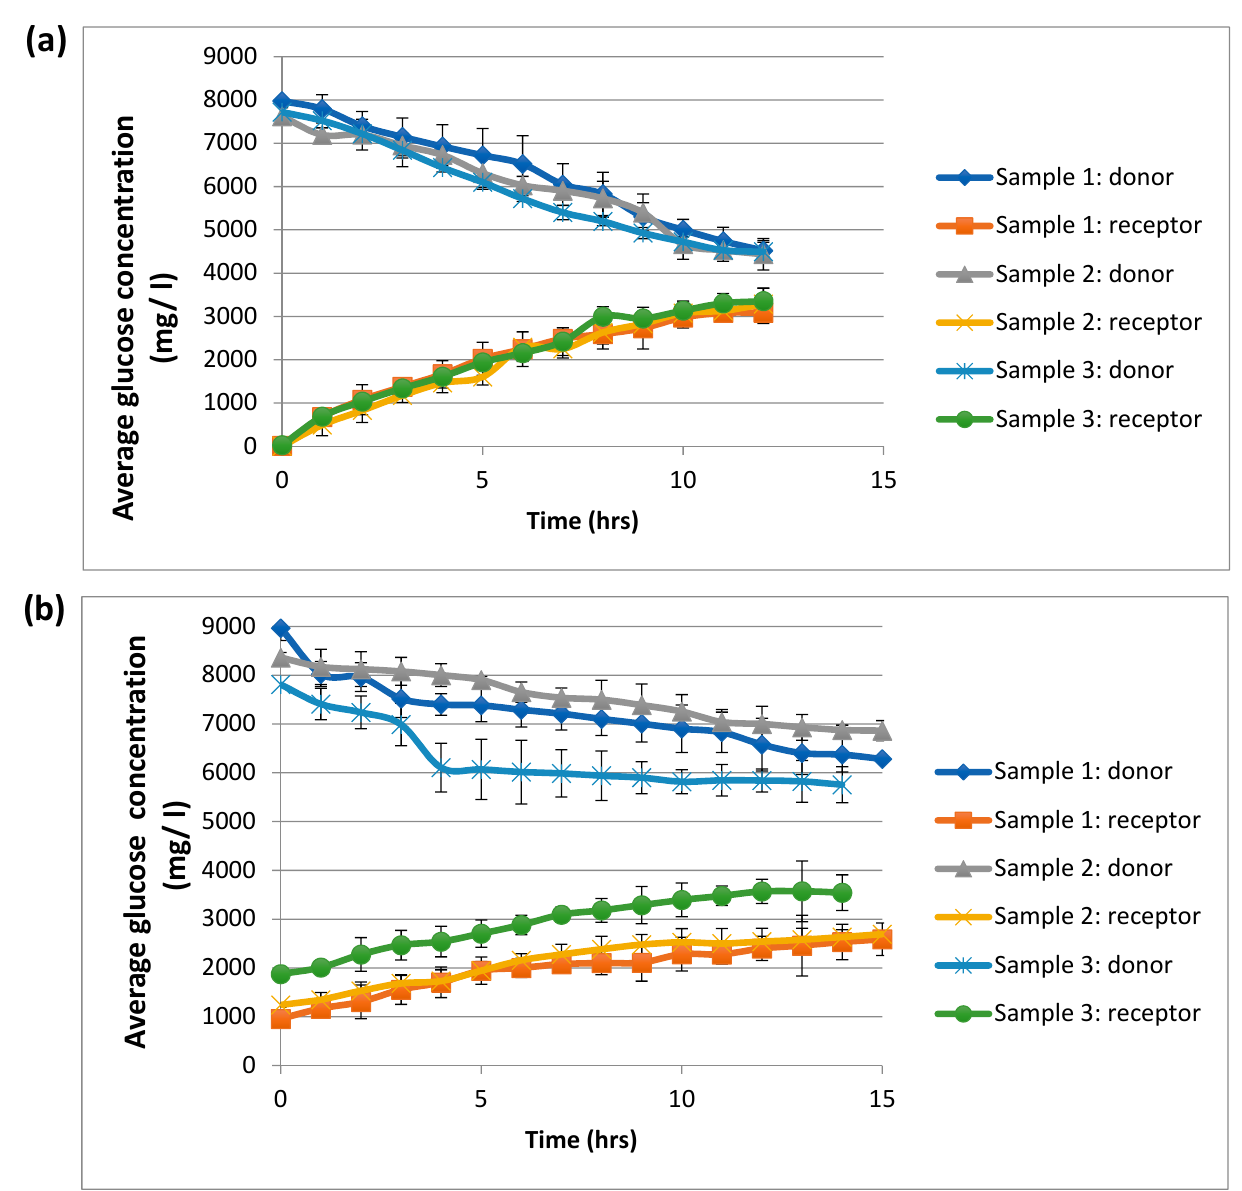
Figure 7. Average glucose concentration change versus time through electrospun scaffolds in ( a ) water and ( b ) CCM. Sample measurement was repeated three times.